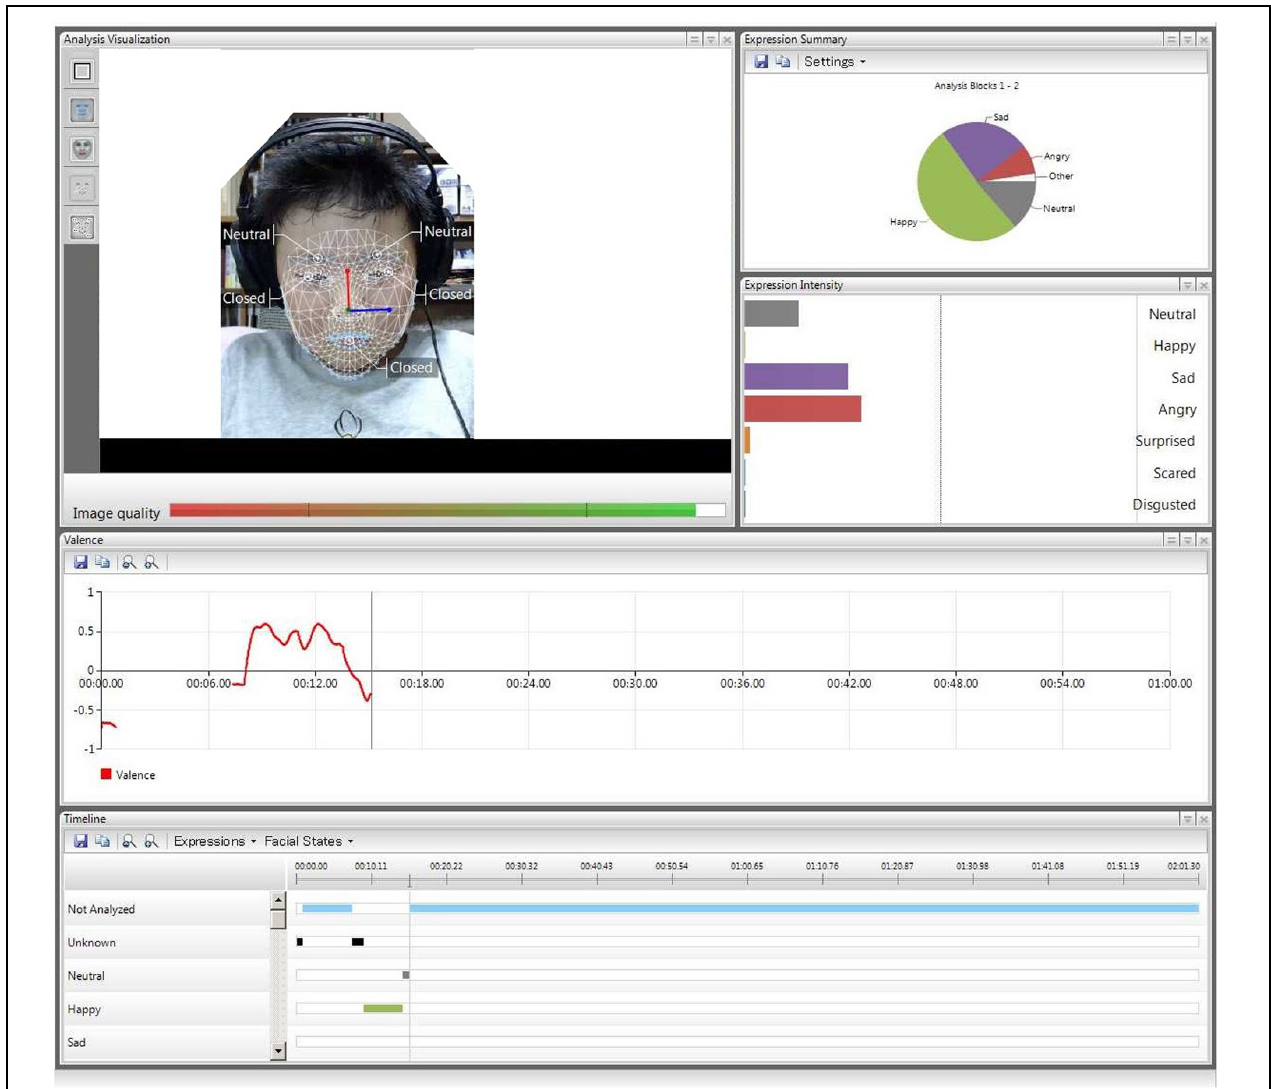
FIGURE 1 | Image of FaceReader software coding facial